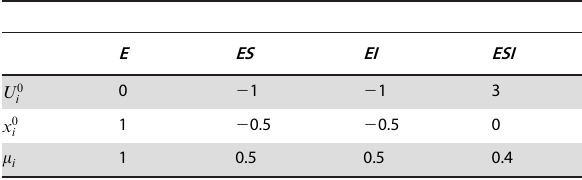
Table 3. Model parameters for enzyme states for the reaction scheme in Fig.